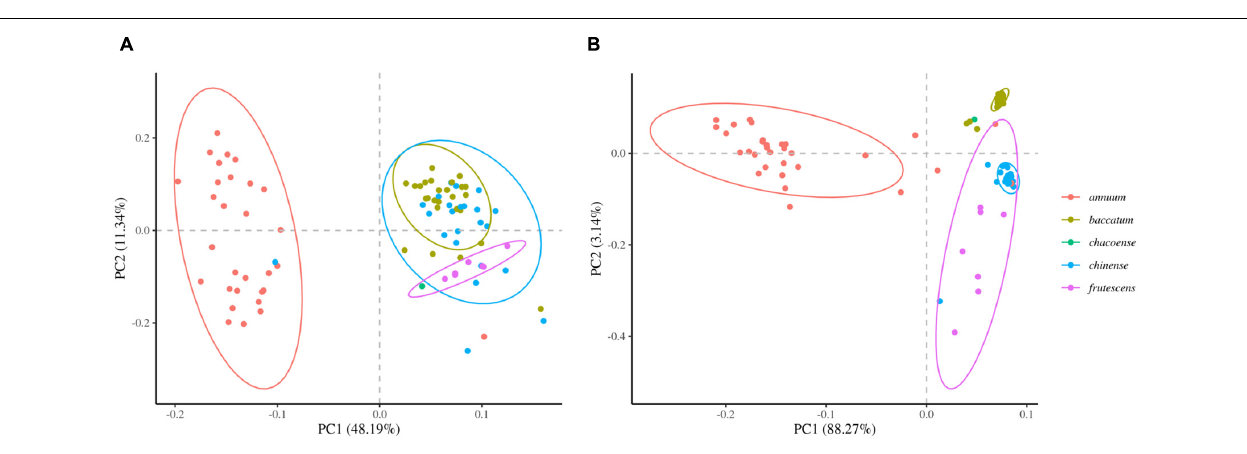
FIGURE 5 | Principal component analysis (PCA) of population structures in natural populations. (A) PCA of genotypes derived from Fluidigm. (B) PCA of genotypes obtained from